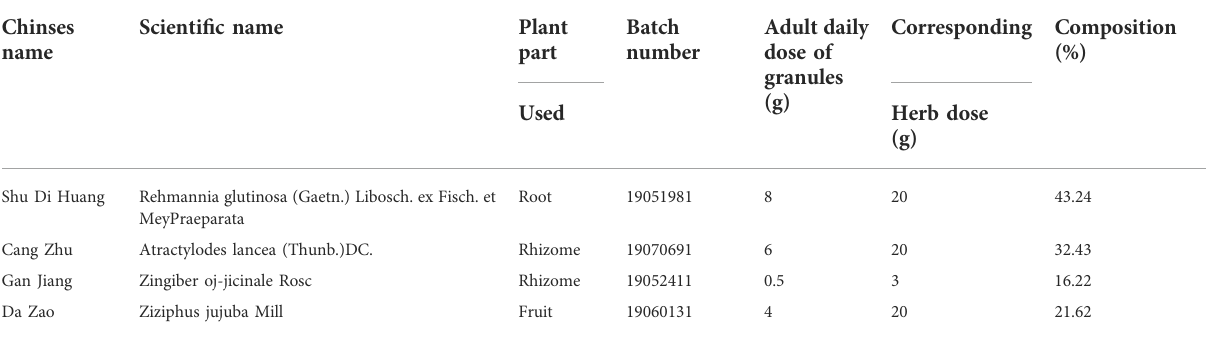
TABLE 1 | Composition of HeidihuangWan.